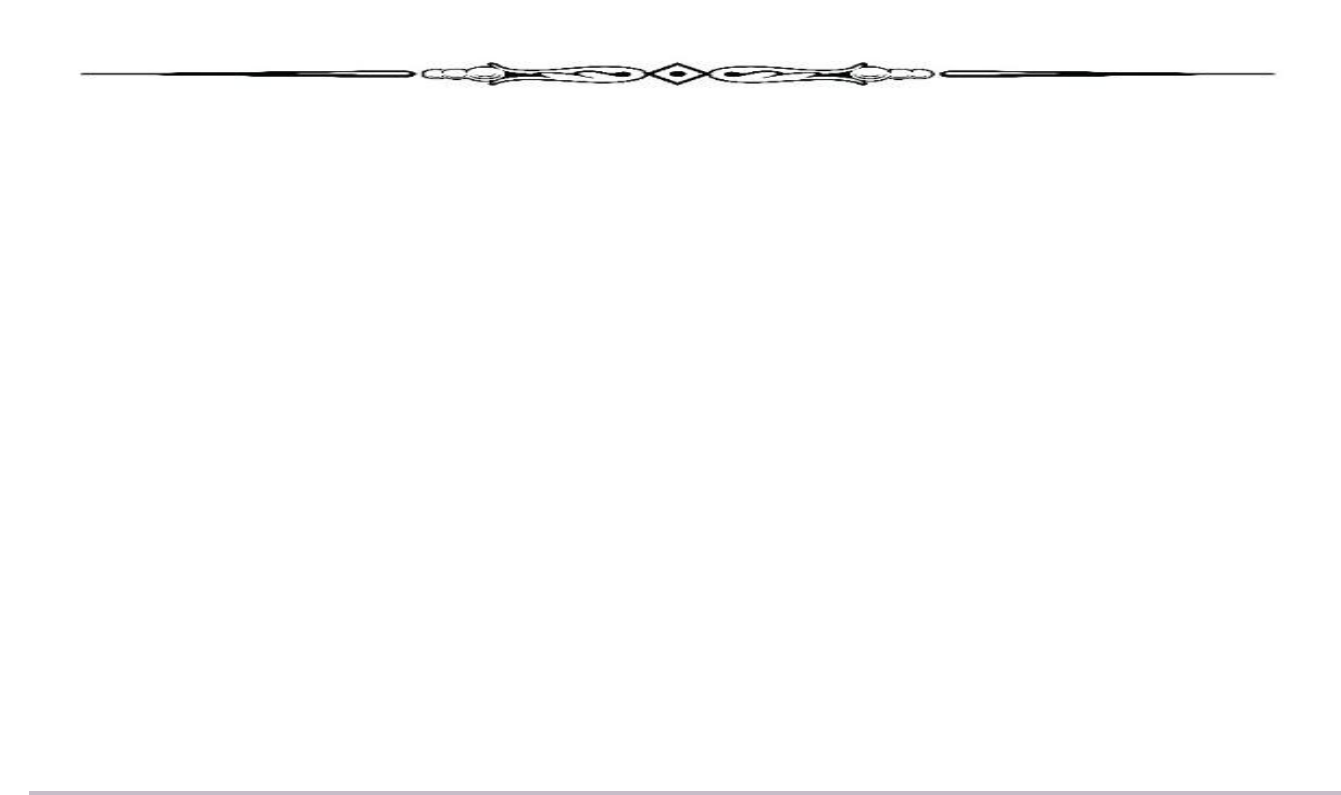
Figure 15: Acceleration - HW,